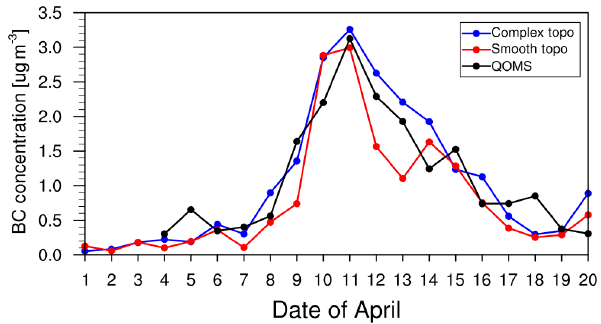
Figure 8. The simulated (colored) and observed (black) temporal variability of surface BC mass concentration at the measurement station during 1–20 April